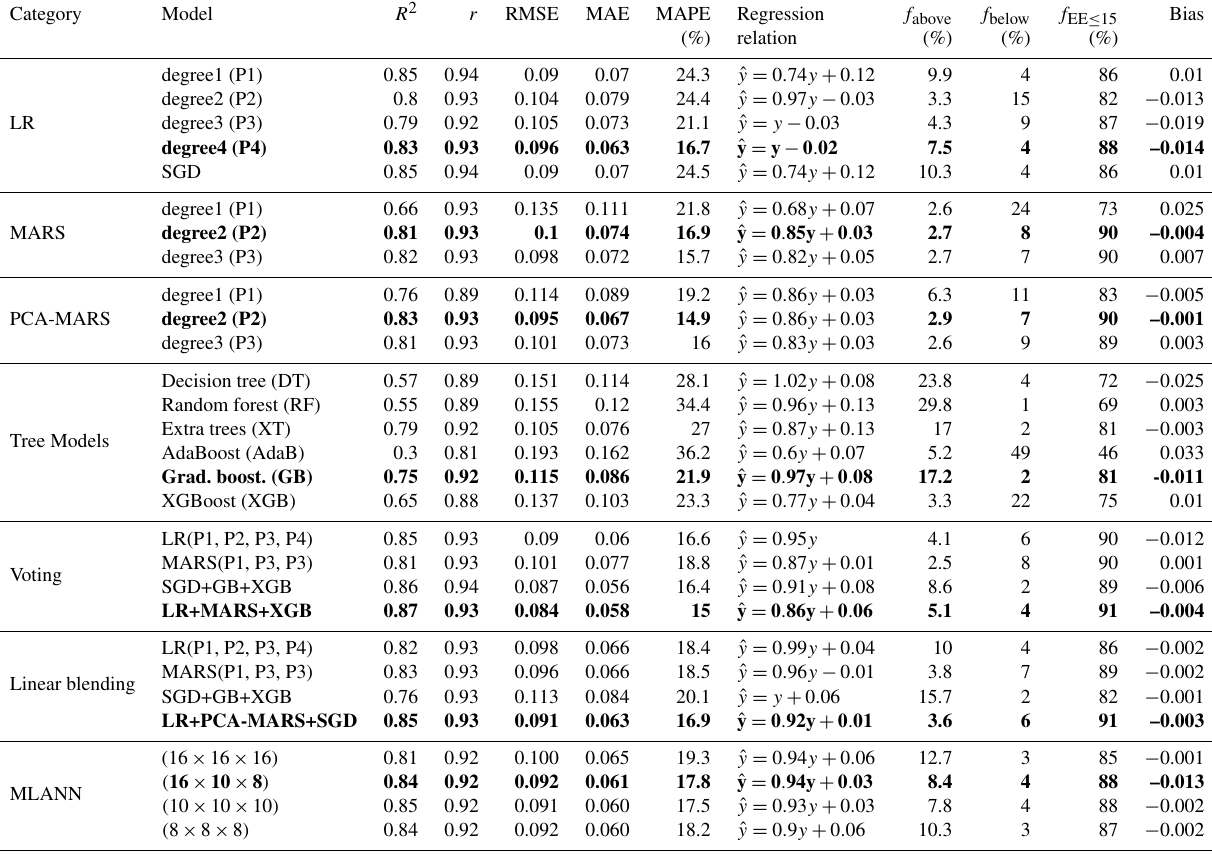
Table B1. Summary of the evaluation results using pyranometer data sampled from Sect. 2.5.2 ( N = 4000). The SciML models were classi- fied into seven categories: linear regression with polynomial terms, multivariate adaptive regression splines (MARS) with polynomial terms, principal component analysis (PCA)-processed MARS, tree models, voting ensembles, linear blending ensembles, and MLANN. Within each category, the models that perform the best are shown in bold. The following metrics are used for evaluation: : R 2 score, Pearson r coefficient ( r ), RMSE, MAE, mean absolute percentage error (MAPE), f above , f EE ≤ 15 , f below , and